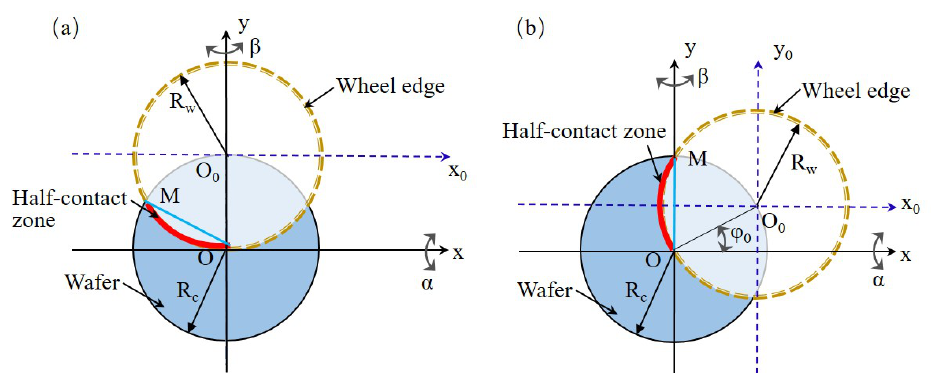
Figure 3. Diagram of classical grinding tool configurations. ( a ) Configuration 1: x -axis is not perpendicular to the arc OM . ( b ) Configuration 2: x -axis is perpendicular to the arc